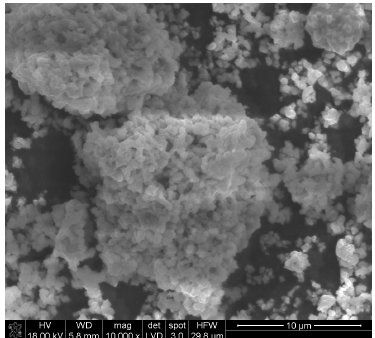
Figure 3. Calculated average crystallite size of Ba 0.9 La 0.1 Zr 0.25 Sn 0.25 In 0.5 O 3 − a as a function of the sintering temperature.